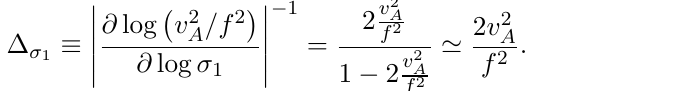
Figure 1 . The (yellow) region that satis(cid:12)es (cid:21) > (cid:26) 1 ; (cid:20) 1 and (cid:27) 1 > 0 is shown for v m h ’ 125GeV, and v A =f = 0 : 223 (left) and 0.123 (right). The regions above the blue, green